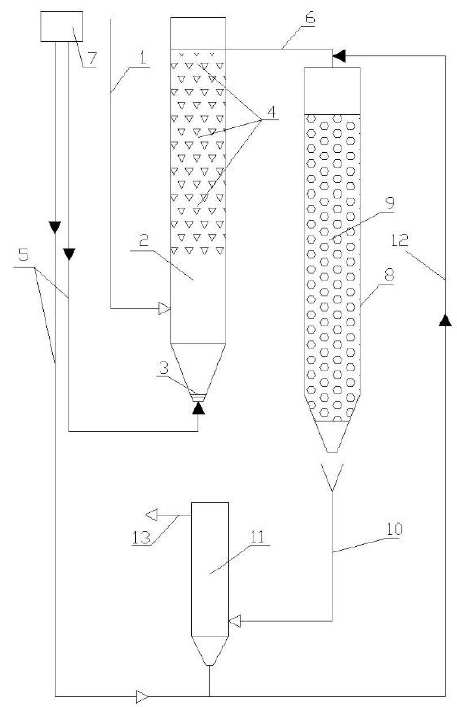
Figure 13. Scheme of the lab-scale bench in stage 2: 1 — wastewater influent; 2 — ASR; 3 — aeration device; 4 — floating carrier; 5 — air supply; 6 — effluent from ASR to TF; 7 — compressor; 8 — TF; 9 — biomass carrier in TF; 10 — discharge of treated wastewater for clarification; 11 — sedimentation tank; 12 — RAS; 13 — effluent.